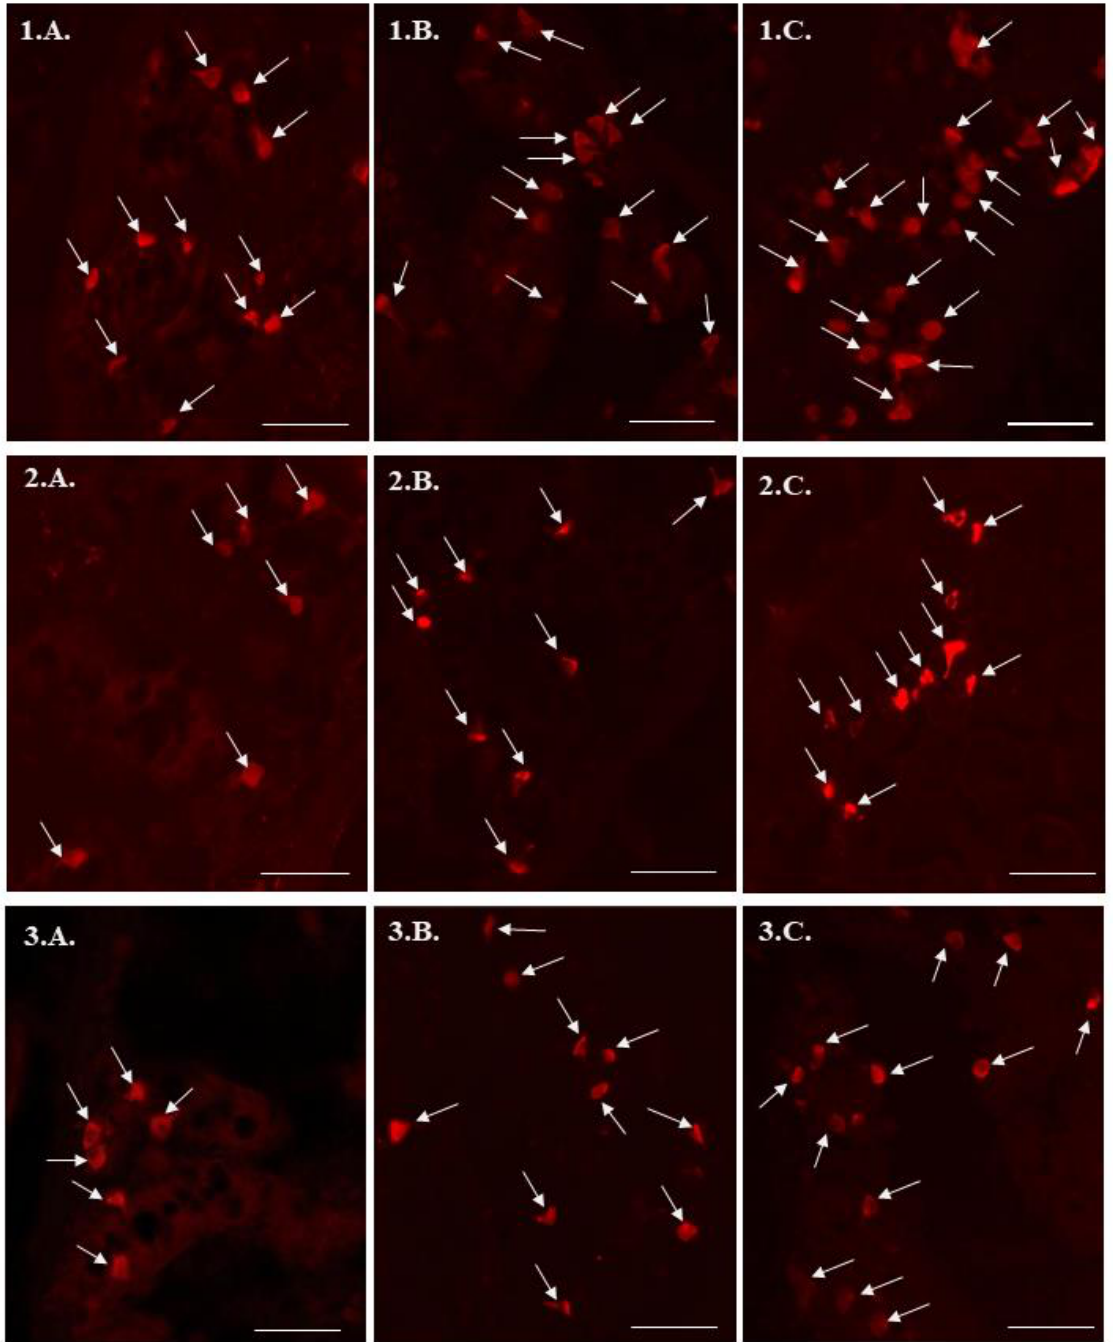
Figure 1. Serotonin – immunoreactive cells (indicated with arrows) in the mucosal layer of the porcine duodenum ( 1 ), jejunum ( 2 ) and ileum ( 3 ) in control animals ( A ), and animals treated with low ( B ) and high ( C ) dose of bisphenol A. Scale bar 50 μm.